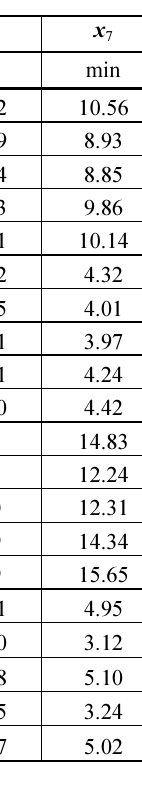
Table 2. Heating energy consumptions, costs and payback periods of the main